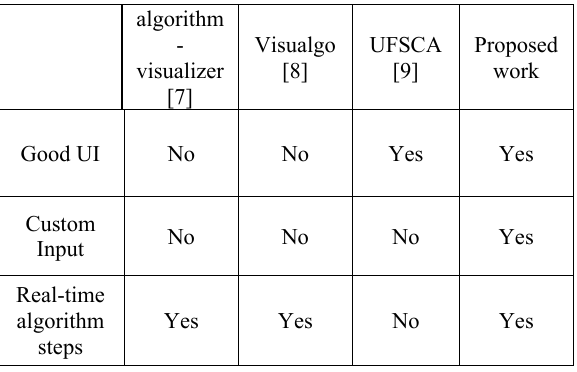
Table 2. Comparative Analysis Table 2 gives brief idea about comparisons of different tools available